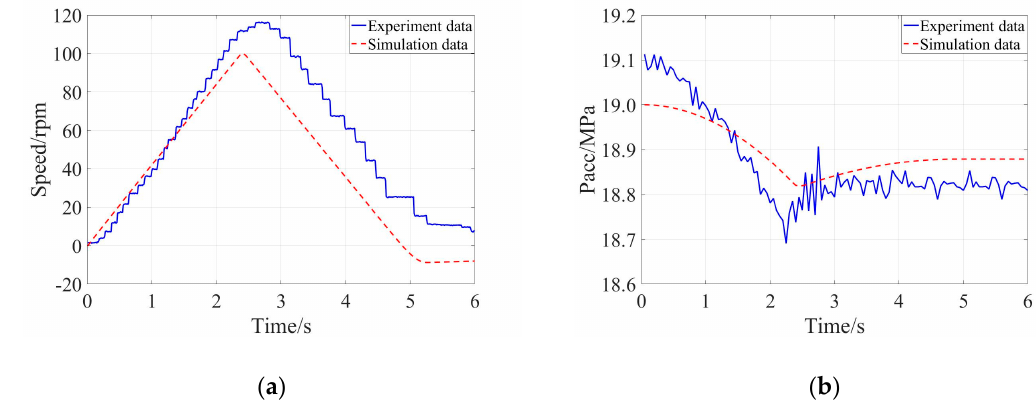
Appl. Sci. 2019 , 9 , x FOR PEER REVIEW